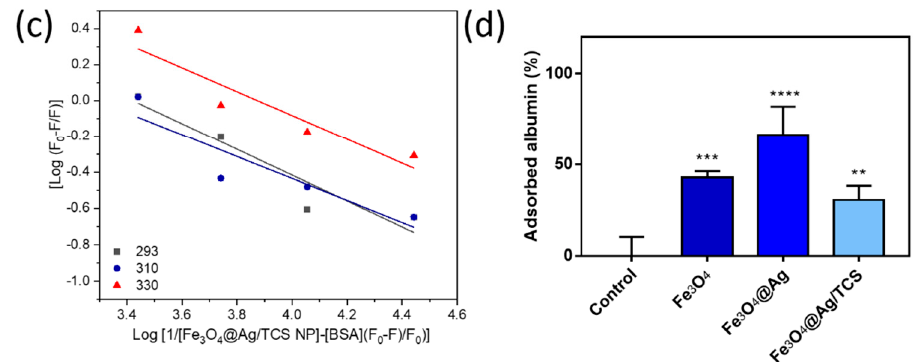
Figure 5. Plot of Log ((F 0 − F)/F) vs. Log (1/([NP] − [BSA](F 0 − F)/F 0 )) for ( a ) Fe 3 O 4